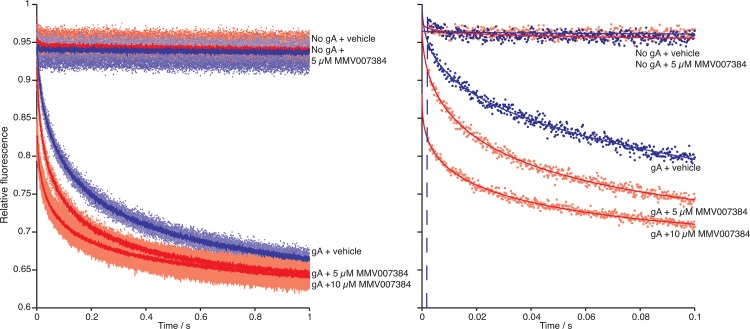
MMV007384 is a bilayer-modifying compound.Fluorescence quench traces showing the effects of 5,5'-Methylenebis [2- (4-methoxyphenyl)-1H-benzimidazole] or MMV007384 [5]) in the gramicidin-based fluorescence assay (GBFA). The panel left shows the results over 1 s. In the presence of 5 or 10 μM of the Malaria Box compound, the quench rate normalized to control (in the absence of the compound) increased to 1.8 (q5) and 2 (q10), respectively. The difference is statistically significant (p < .0001). The right panel shows the average trace for a single run at higher time resolution.